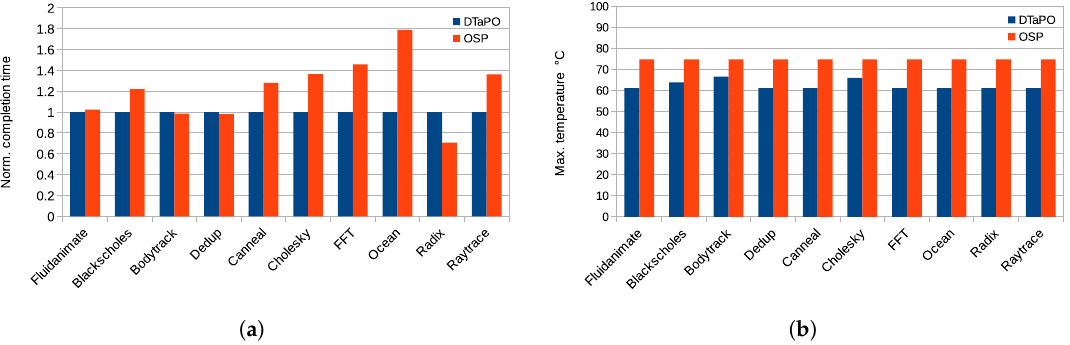
Figure 12. Comparison results of running 10 applications from SPLASH2 and PARSEC: ( a ) comparison of the computational efficiency in term of completion time; and ( b ) comparison of thermal efficiency in term of peak